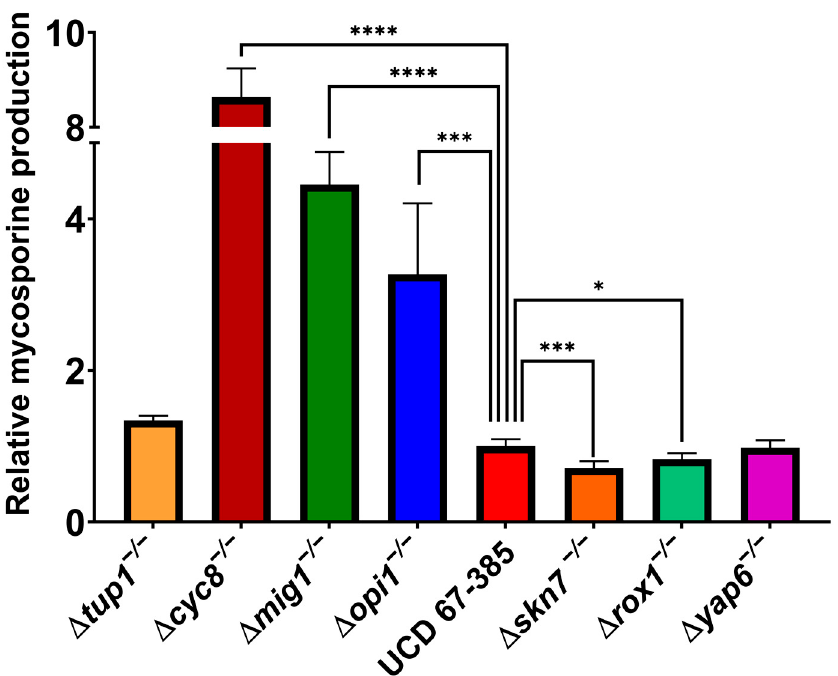
Figure 6. Mycosporine production of the transcription factor gene mutants relative to the parental P. rhodozyma strain UCD 67-385. The strains were grown in YNB medium containing 2% glucose. One-way ANOVA followed by Fisher’s LSD test (* p -value < 0.05, *** p -value < 0.001; **** p -value < 0.0001). Error bars represent standard